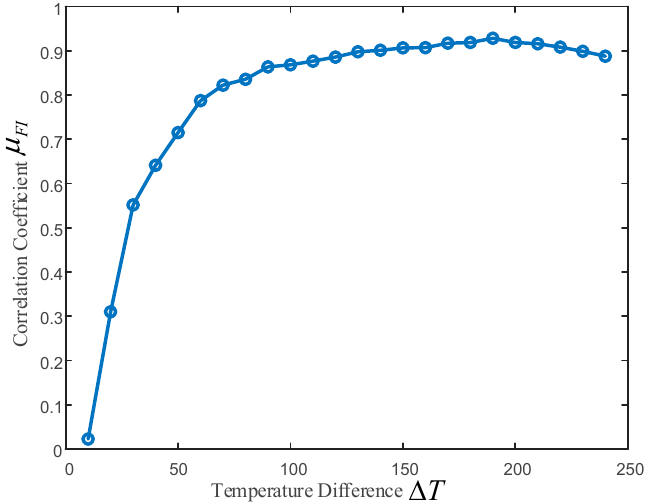
Figure 5. The correlation coefficient changes with the temperature difference of the atmospheric turbulence emulation pool.